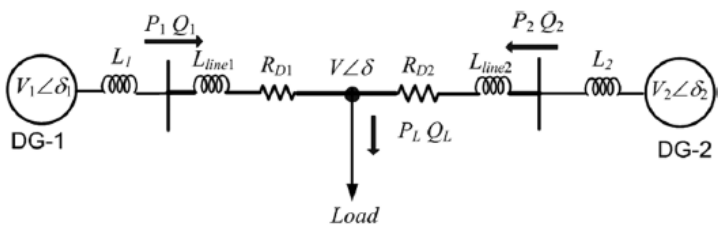
Figure 4. Power distribution between DGs [28].